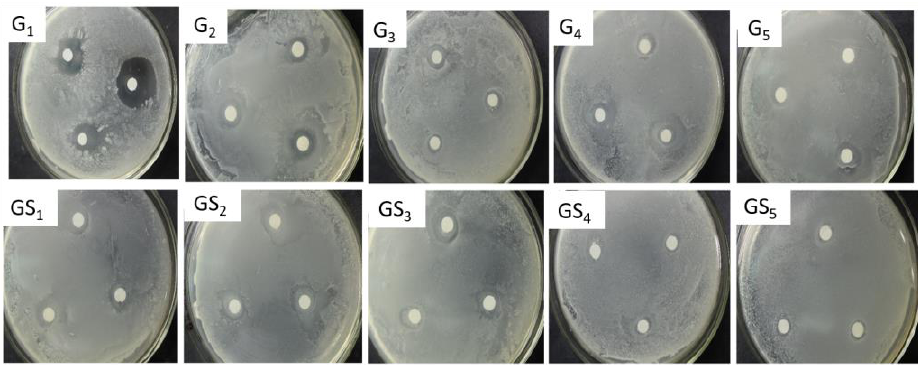
Figure 7. Inhibitory effect of purified compounds from DHP on the growth of E. coli. Legend: G 1 – G 5 : compounds purified from the ether fraction of DHP-G by preparative chromatography; GS 1 – GS 5 : compounds purified from the ether fraction of DHP-GS by preparative chromatography.